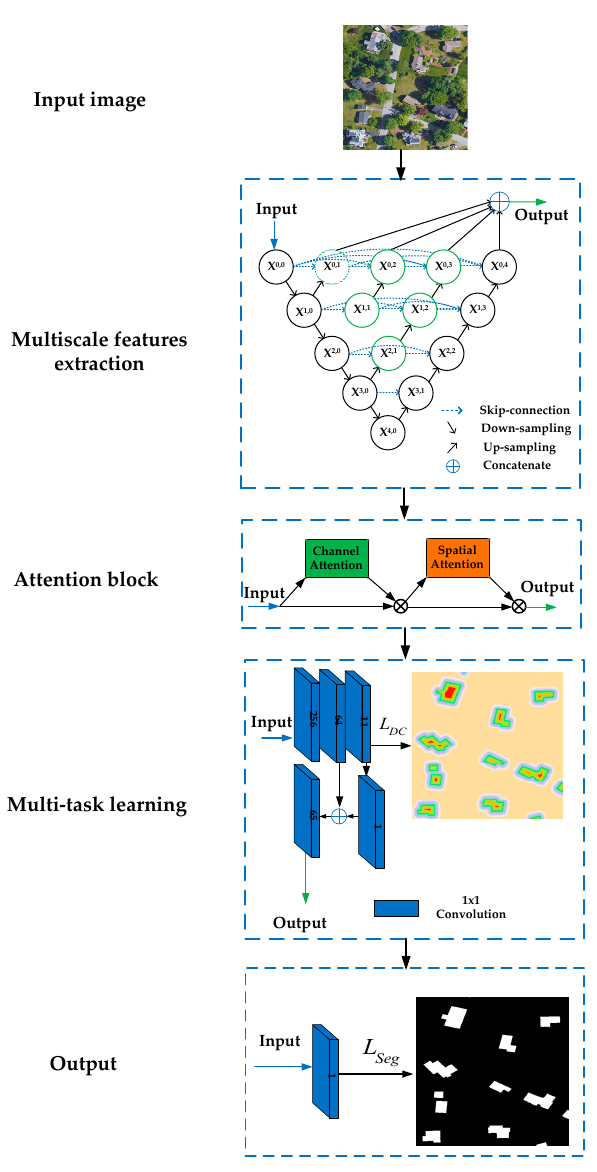
Figure 1. The architecture of the proposed AEUNet++ (the output of previous stage is the input of the next stage).